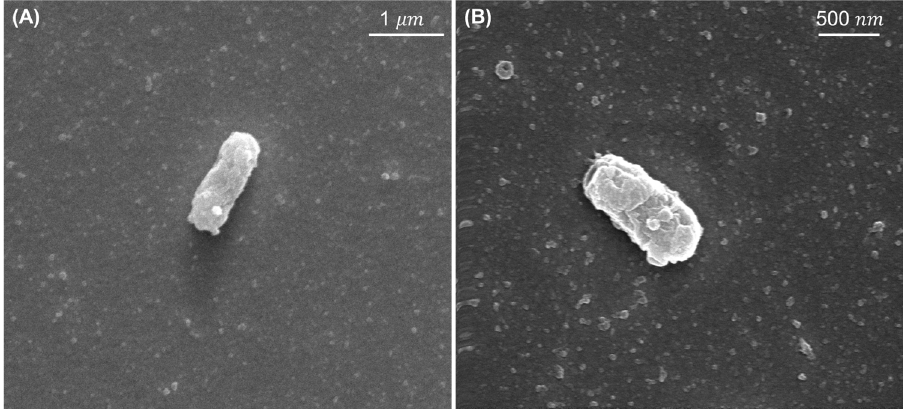
Figure 5. Salmonella with 100 nm ‐ AuNPs were captured with a scale bar of 1 μ m ( A ) and 500 nm ( B ). AuNPs were attached via a biotin ‐ streptavidin reaction.